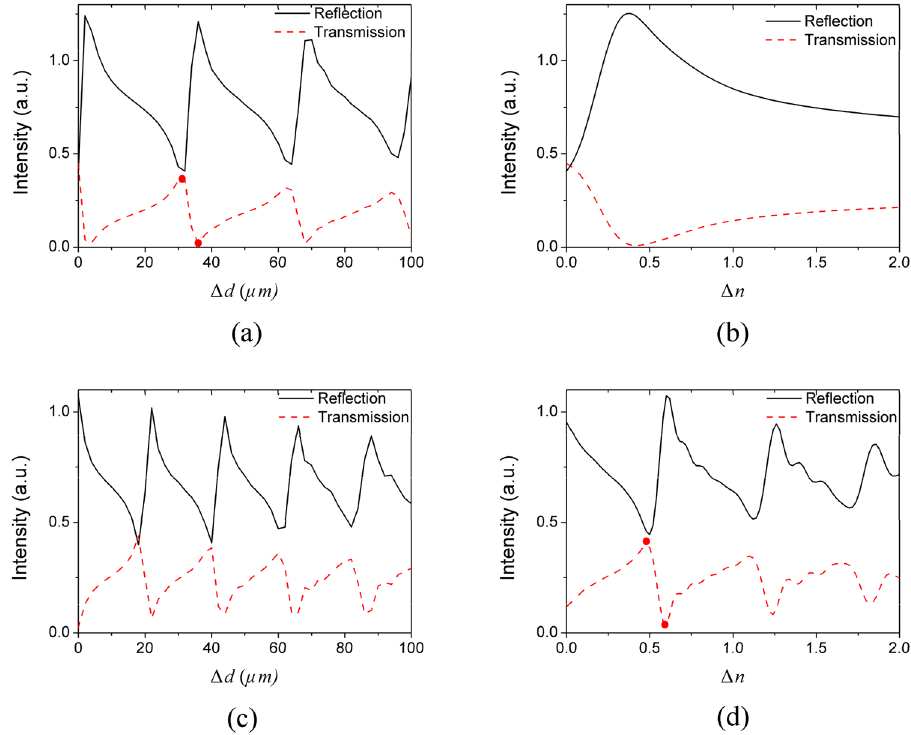
Figure 3. Intensity of surface waves before (black solid line) and after (red dashed line) the single grey groove of varying depth, Δ n = 0 ( a ), Δ n = 0.5 ( c ); and various refractive indices, Δ d = 0 μm ( b ), Δ d = 40 μm ( d